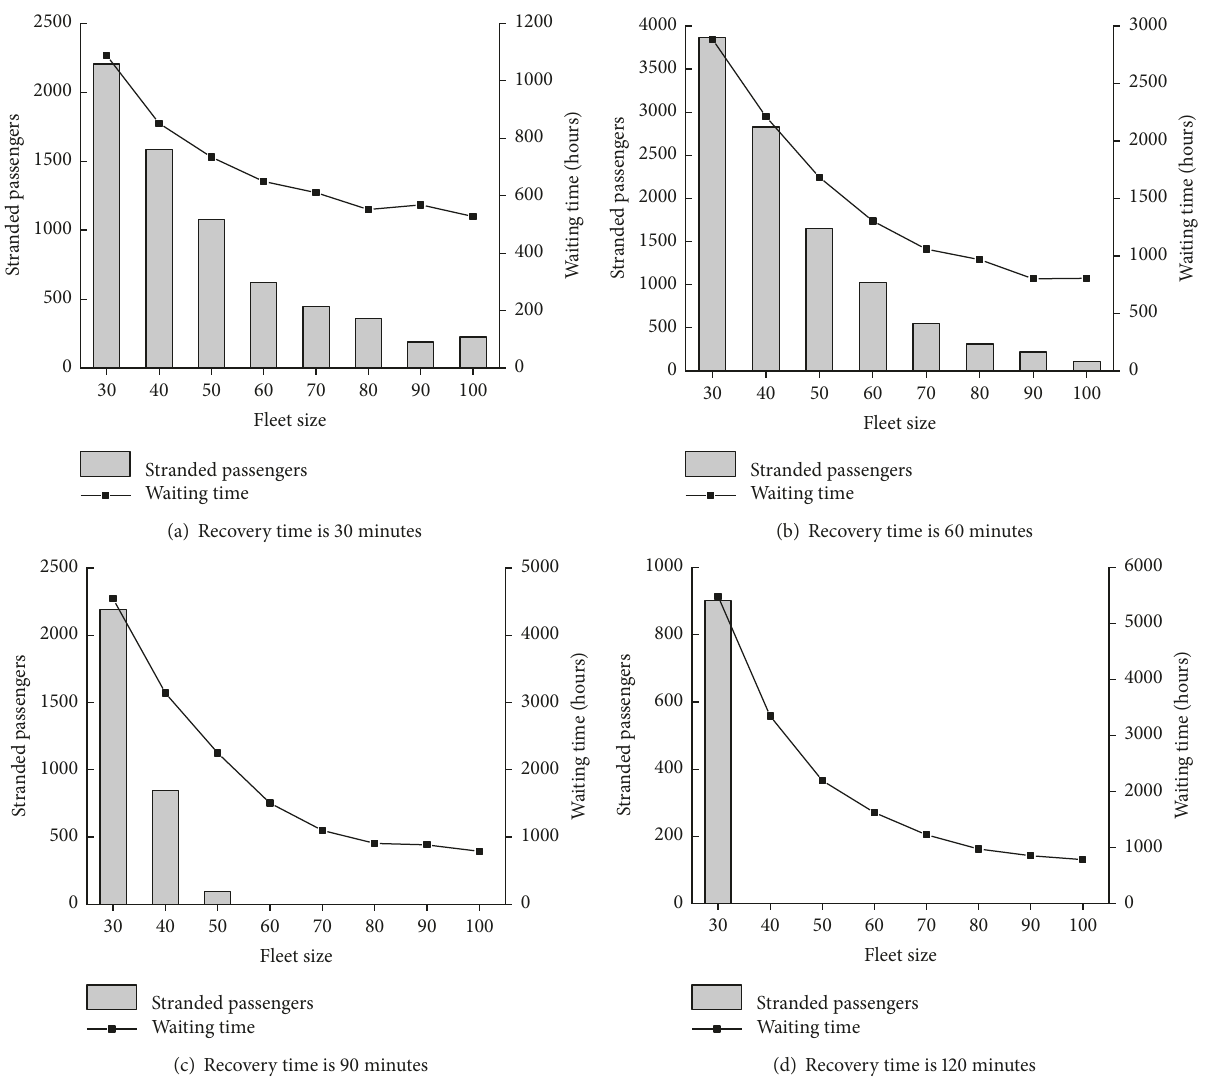
Figure 11: Waiting time and stranded passengers for different recovery